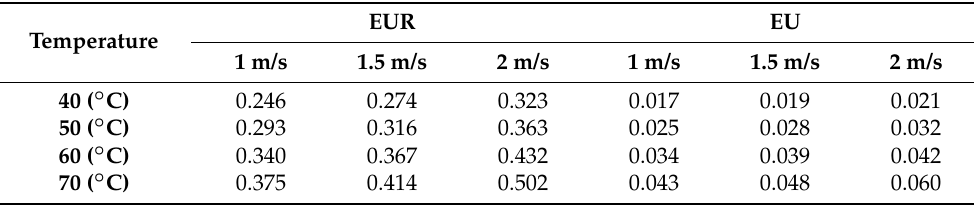
Table 2. Variation of EU (kJ/s) and EUR (%) with air temperature and velocity.